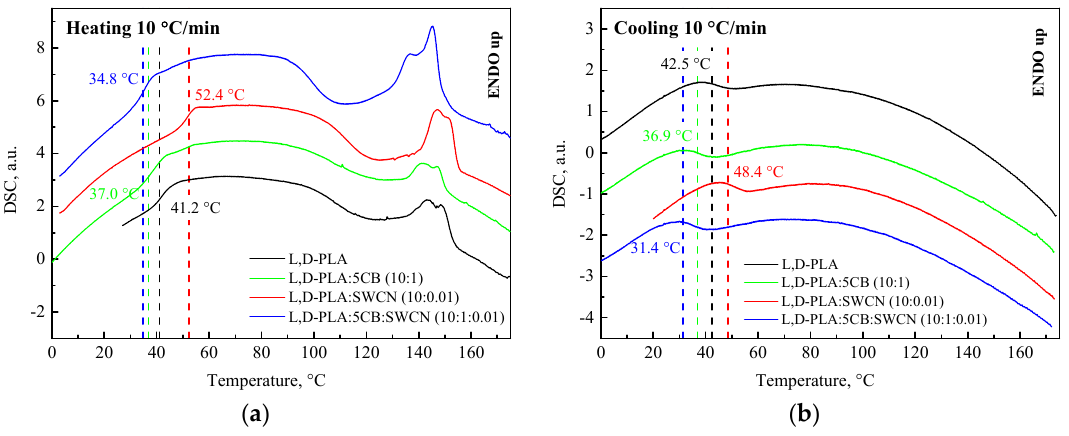
Figure 1. Differential scanning calorimetry (DSC) curves with glass transition (T g ) registered during heating ( a ) and cooling ( b ) for the created hybrid layers and pure L,D-poly(lactic acid). All optical textures were registered at room temperature under a polarizing microscope with crossed polarizers as well as without an analyzer (with one polarizer). The microphotographs taken for the pure polymers and created hybrid layers are presented in Figure 2 and Figures S2 and S3 in the Supplementary Materials. As one can see, the pure L,D-PLA layer is dark, while the admixtures changed them significantly (Figure 2). The admixture of 5CB makes the texture colored, while after the addition of SWCN, it becomes brighter. Ternary hybrid layers were brighter and more colored when compared with the layer of pure L,D-PLA.